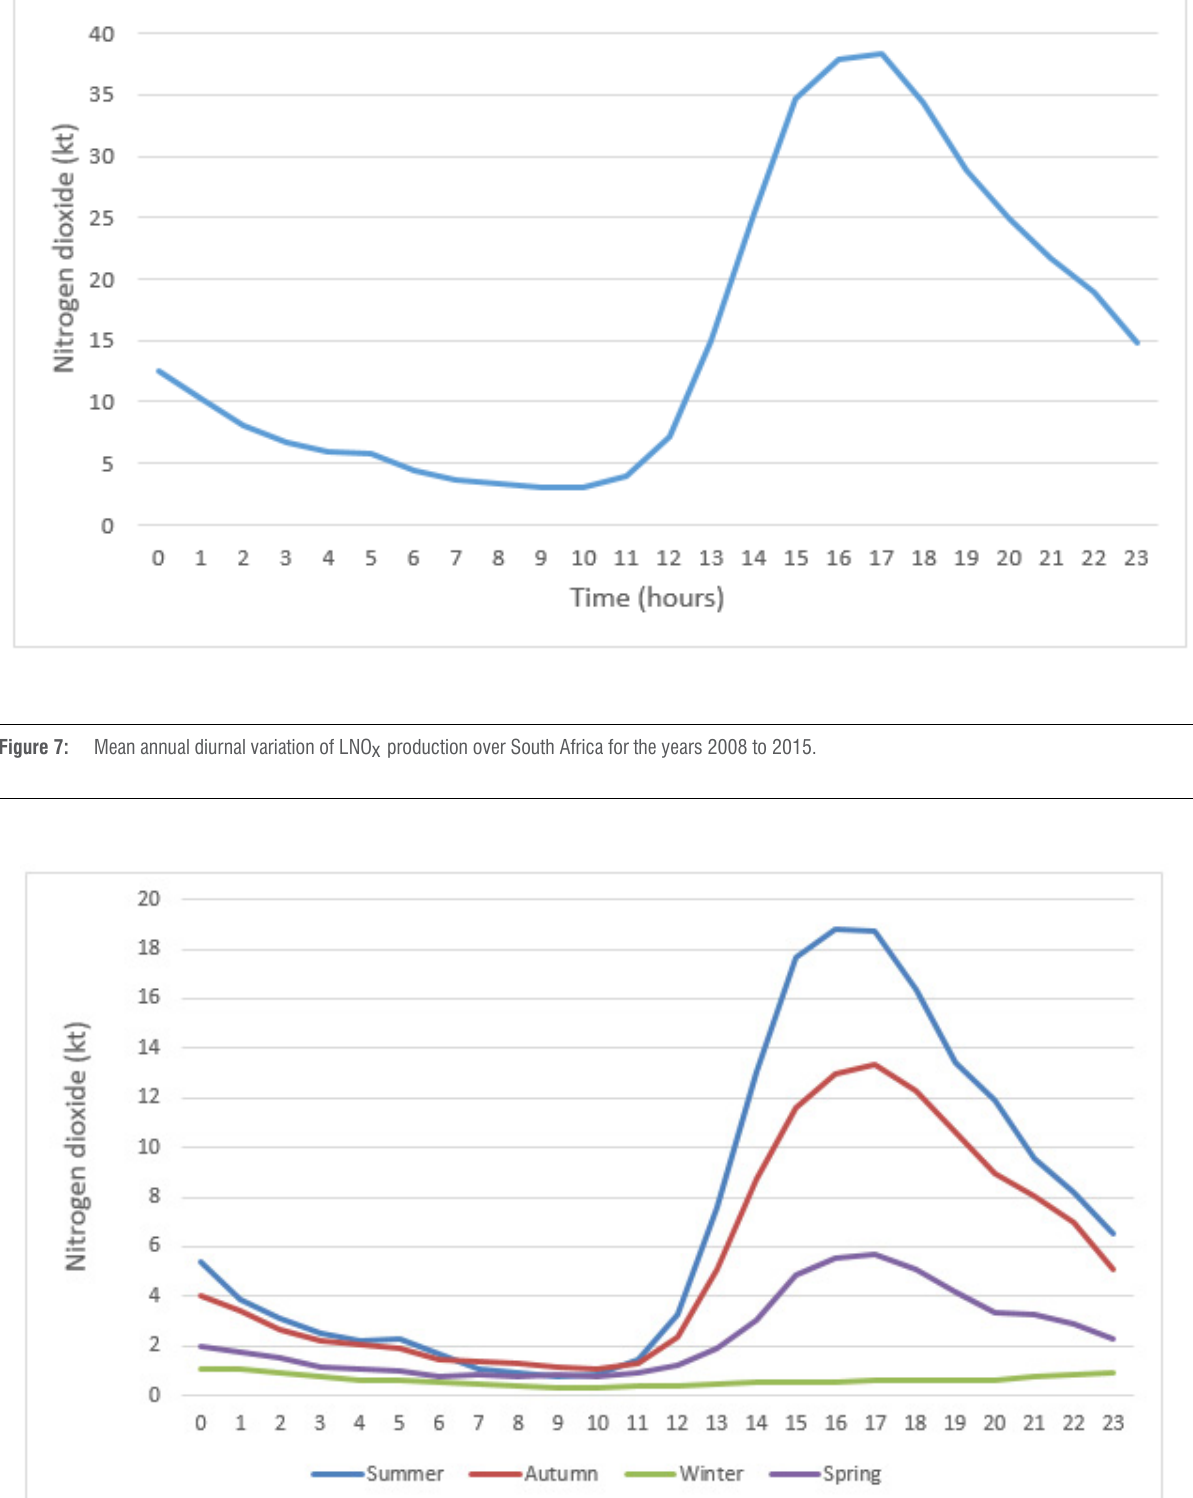
Research Article https://doi.org/10.17159/sajs.2021/8035